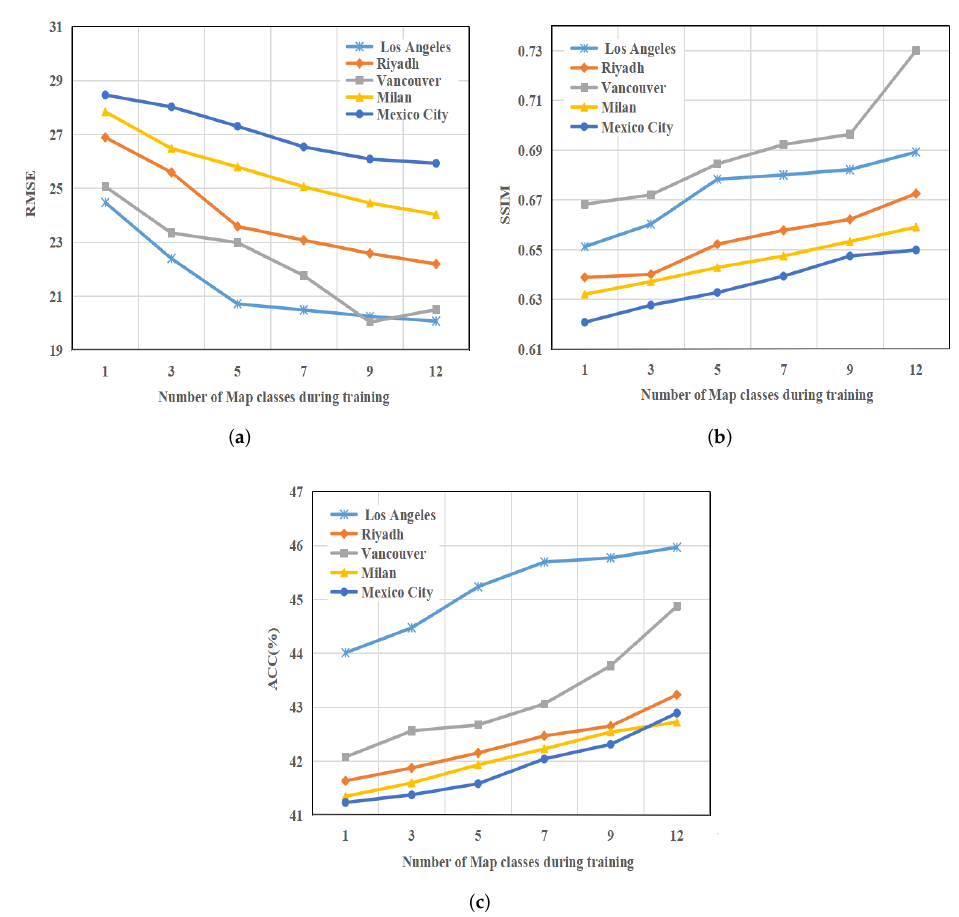
Figure 6. Remote sensing image-to-map translation performance of RSMT by deploying different numbers of input Map classes during training on five testing datasets. During training, the perfor- mance of RSMT is positively related tos the number of Map classes. ( a ) Trend chart of RMSE scores for RSMT-K (K = 1, 3, 5, 7, 9, 12) on five testing datasets. ( b ) Trend chart of SSIM scores for RSMT-K (K = 1, 3, 5, 7, 9, 12) on five testing datasets. ( c ) Trend chart of ACC scores for RSMT-K (K = 1, 3, 5, 7, 9, 12) on five testing